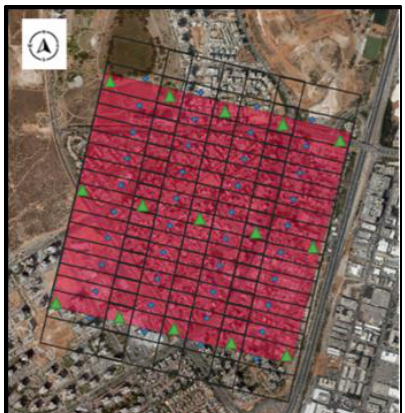
Figure (2a) : distribution of GCP for dual frequency GPS